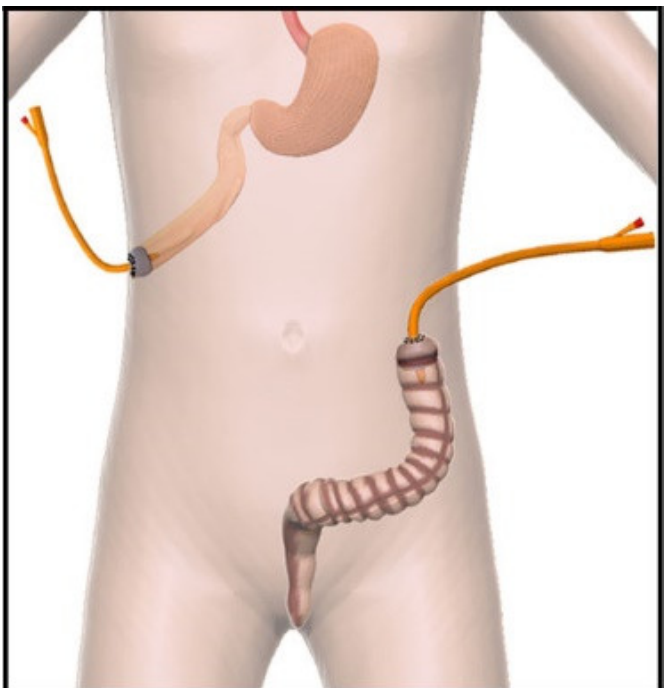
Figure 1. Tube-stoma technique. Representative pictures of tube stoma fashioned in the proximal bowel. In this case, a Foley tube is placed into the lumen of the proximal bowel with the balloon inflated. A double purse-string suture is securing the balloon into the bowel. The same technique is performed in the distal bowel where the tube is placed with the same technique into the lumen of descending colon. The balloon is inflated.